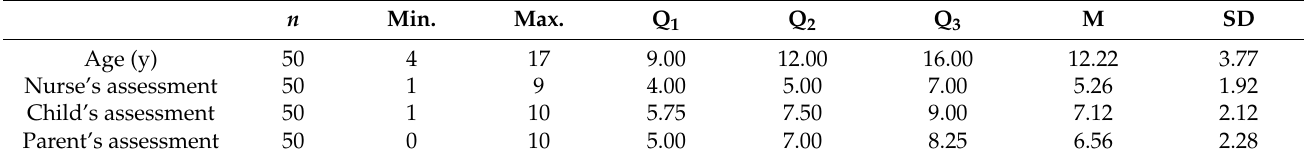
Table 2. Numerical Rating Scale pain scores as assessed by nurses, children and parents. Patients were ≥ 4 years of